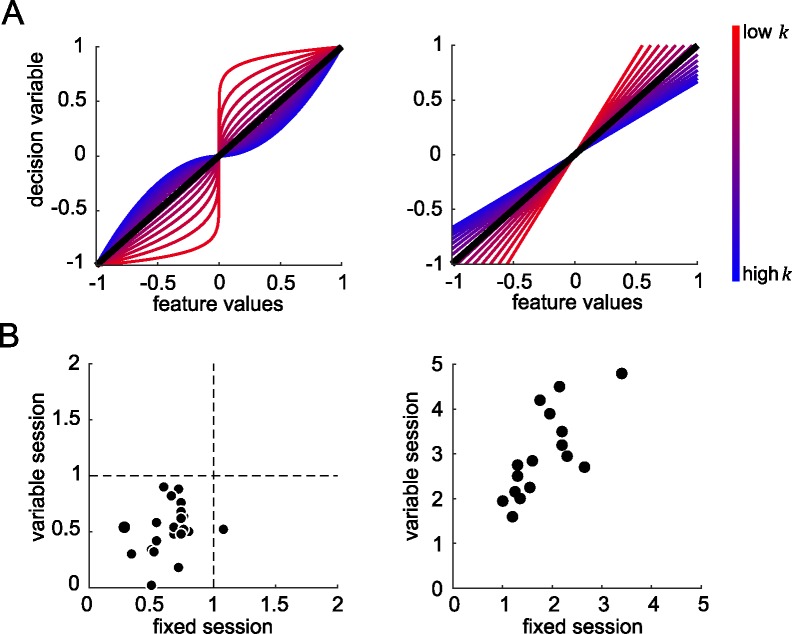
Mapping sensory inputs to decision values.(A) Left panel: the different functions that map feature values (angles relative to the reference in radians) to decision values for the power model. Coloured lines represent functions for different values of k from 0.1 to 2, with low values represented by reddish lines and high values represented by bluish lines. Right panel: the equivalent functions for the equivalent gain linear model. In the left and right panels, models with equivalent gain are represented with lines of equivalent colour. (B) The best fitting k values (left panel) and s values (right panel) in human for fixed reference (x-axis) and variable reference session (y-axis).